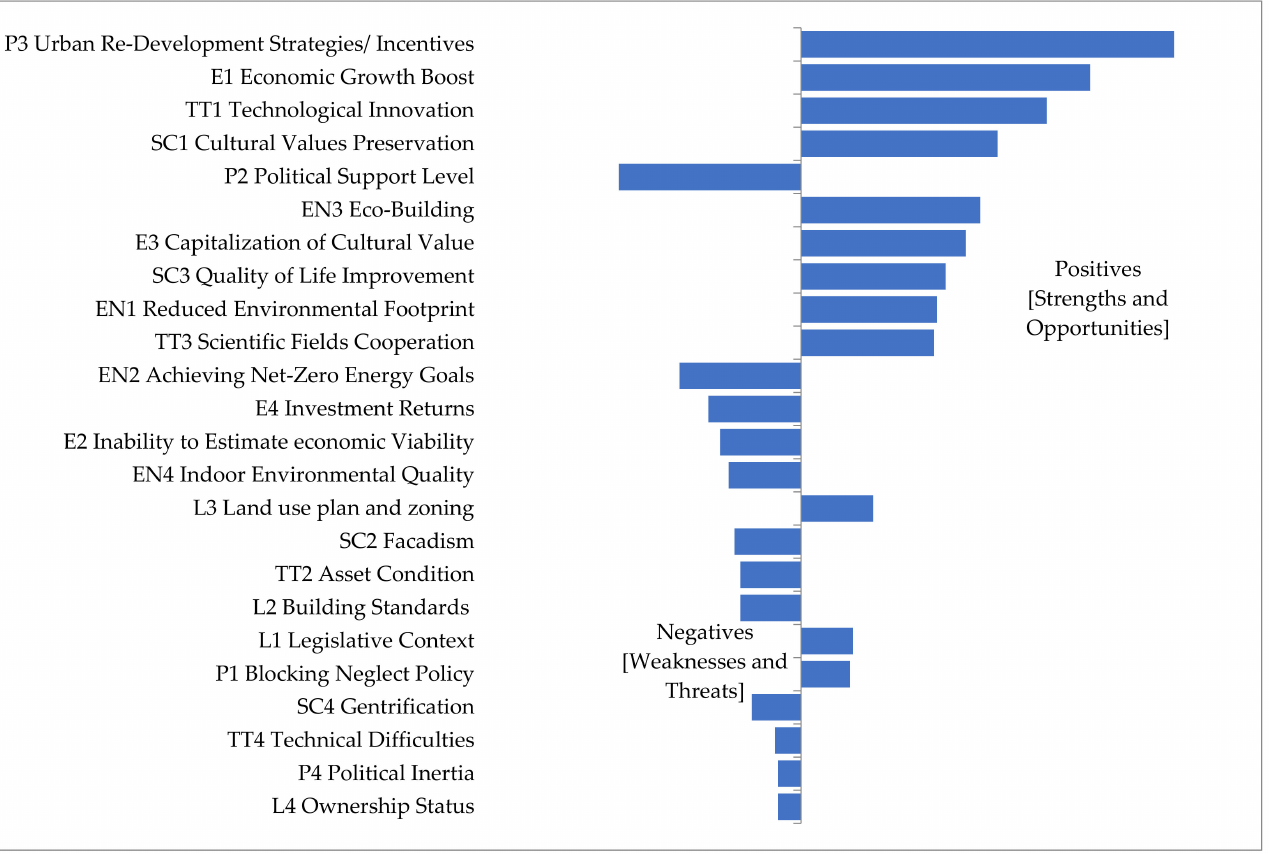
Figure 4. Indicator values, graphically.